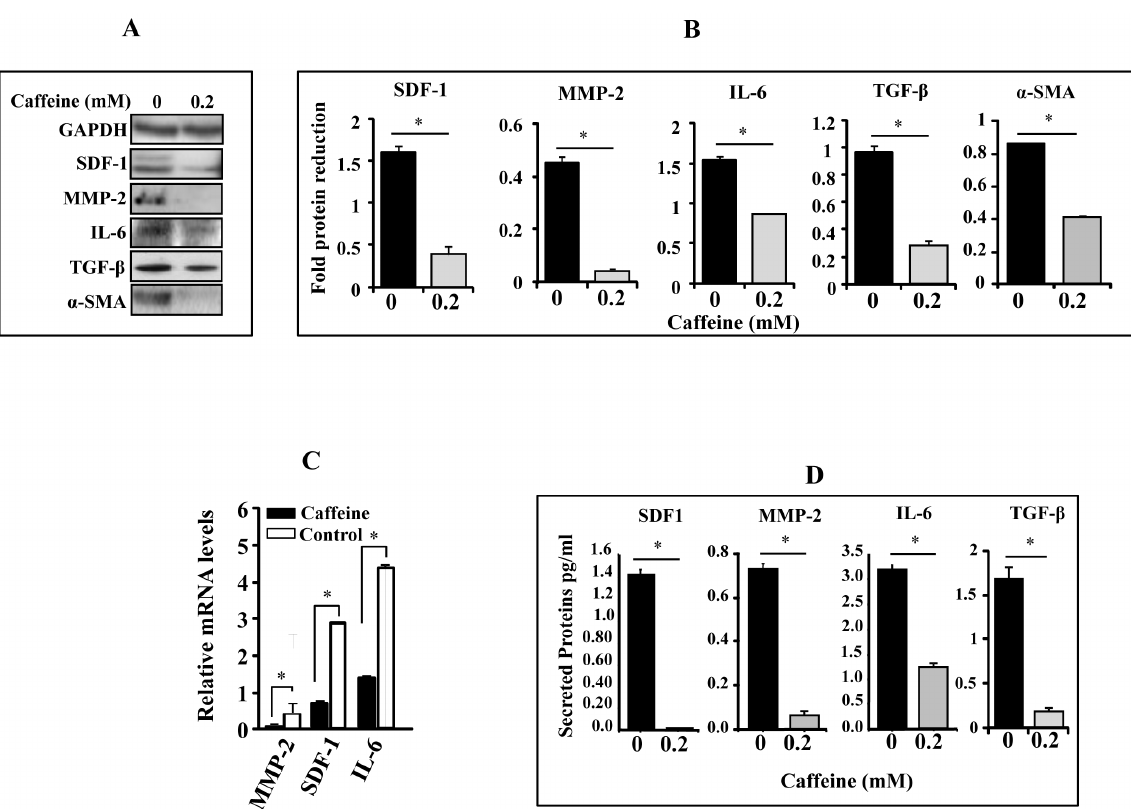
Figure 2. Caffeine inhibits the expression/secretion of SDF1, IL-6, MMP-2 and TGF- b˜ . CAF-180 cells were either sham-treated or challenged with caffeine for 1 hr. (A) Whole cell lysates were prepared and used for immunoblotting analysis using the indicated antibodies. (B) Histograms show the expression levels of the indicated proteins. The values were determined by densitometry and normalized against GAPDH. (C) Total RNA was prepared and used to assess the level of the indicated genes by qRT-PCR. The obtained values were normalized against b -actin. (D) Secreted levels of proteins were determined in SFCM by ELISA and shown in the histograms. Error bars represent means 6 S.D. *: p , 0.05.